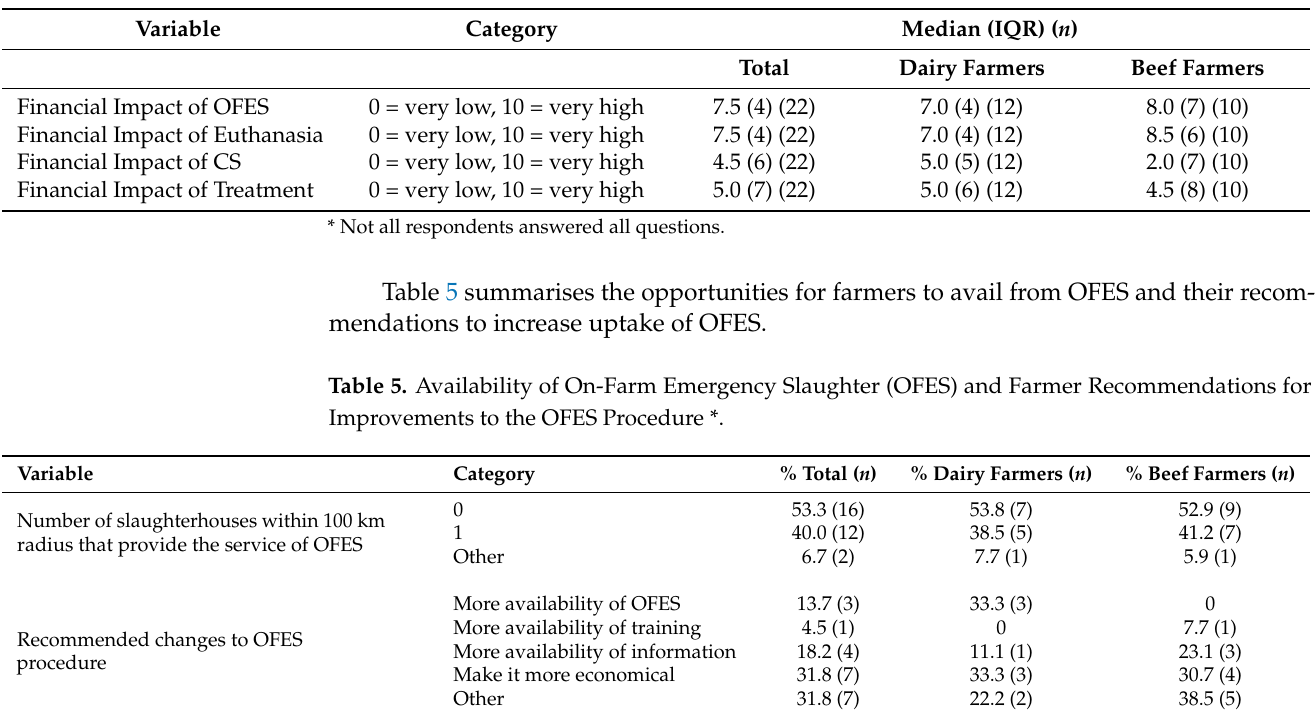
Table 4. Financial Impact for Farmers of On-Farm Emergency Slaughter (OFES), Euthanasia, Casualty Slaughter (CS), or Treatment *.